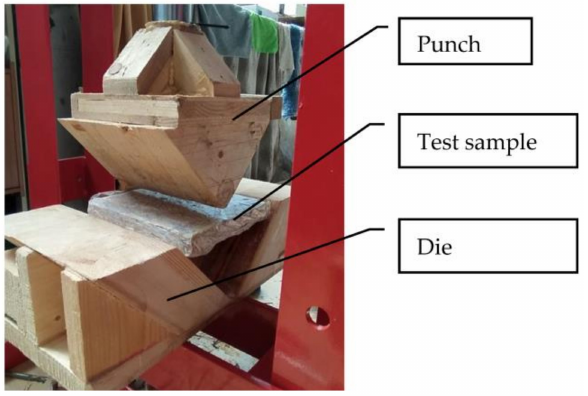
Figure 4. The punch–die system used to perform the bending